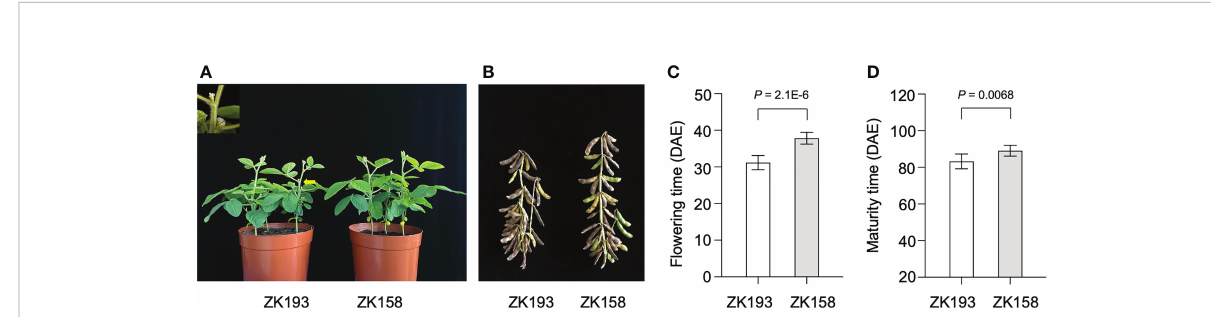
FIGURE 1 The phenotype of ZK193 and ZK158 under short-day (SD) conditions. (A, B) Flowering and maturity time of ZK193 and ZK158 under SD conditions. (C) Flowering time. Flowering time was recorded at the R1 stage. (D) Maturity time. Maturity time was recorded at the R8 stage. DAE (days after emergence). All data were given as mean ± SD (standard deviation, n = 10 plants). A Student ’ s t-test was used to generate the P